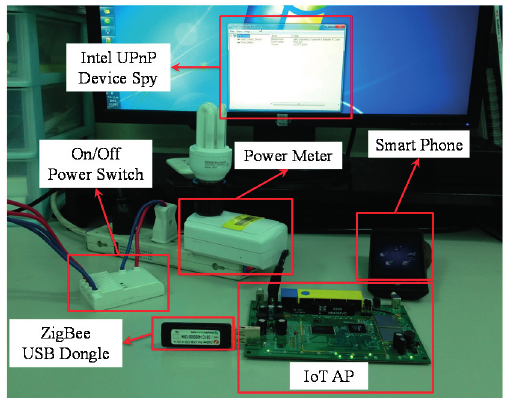
Figure 7. Smart Home system established by the IoT